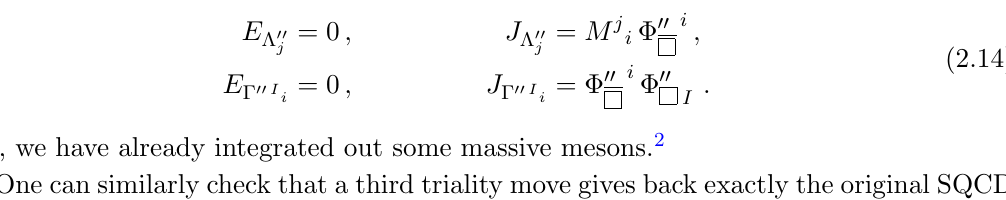
= (0 ; 2) SQCD. The fermi (cid:12)elds (cid:10) N